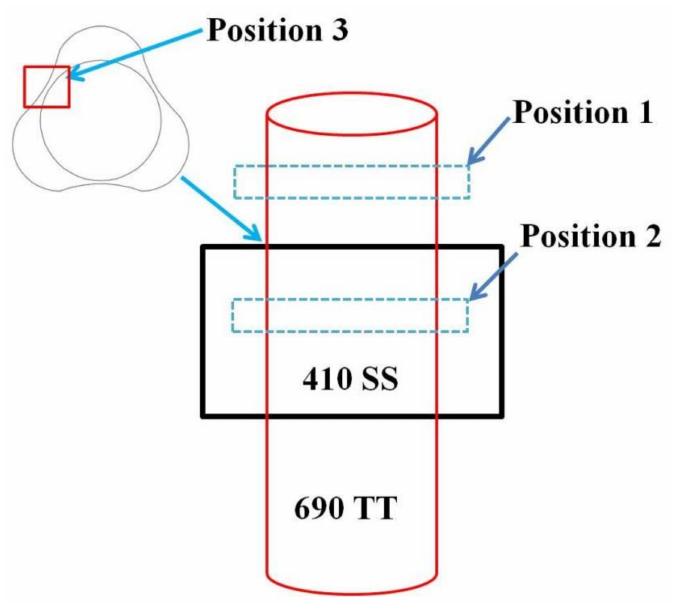
Figure 1. Schematic diagram of the assembled unit used in the present work. Positions 1 and 2 are on the surface of the SG (Alloy 690TT) and position 3 is on the surface of the TSP (410 SS).